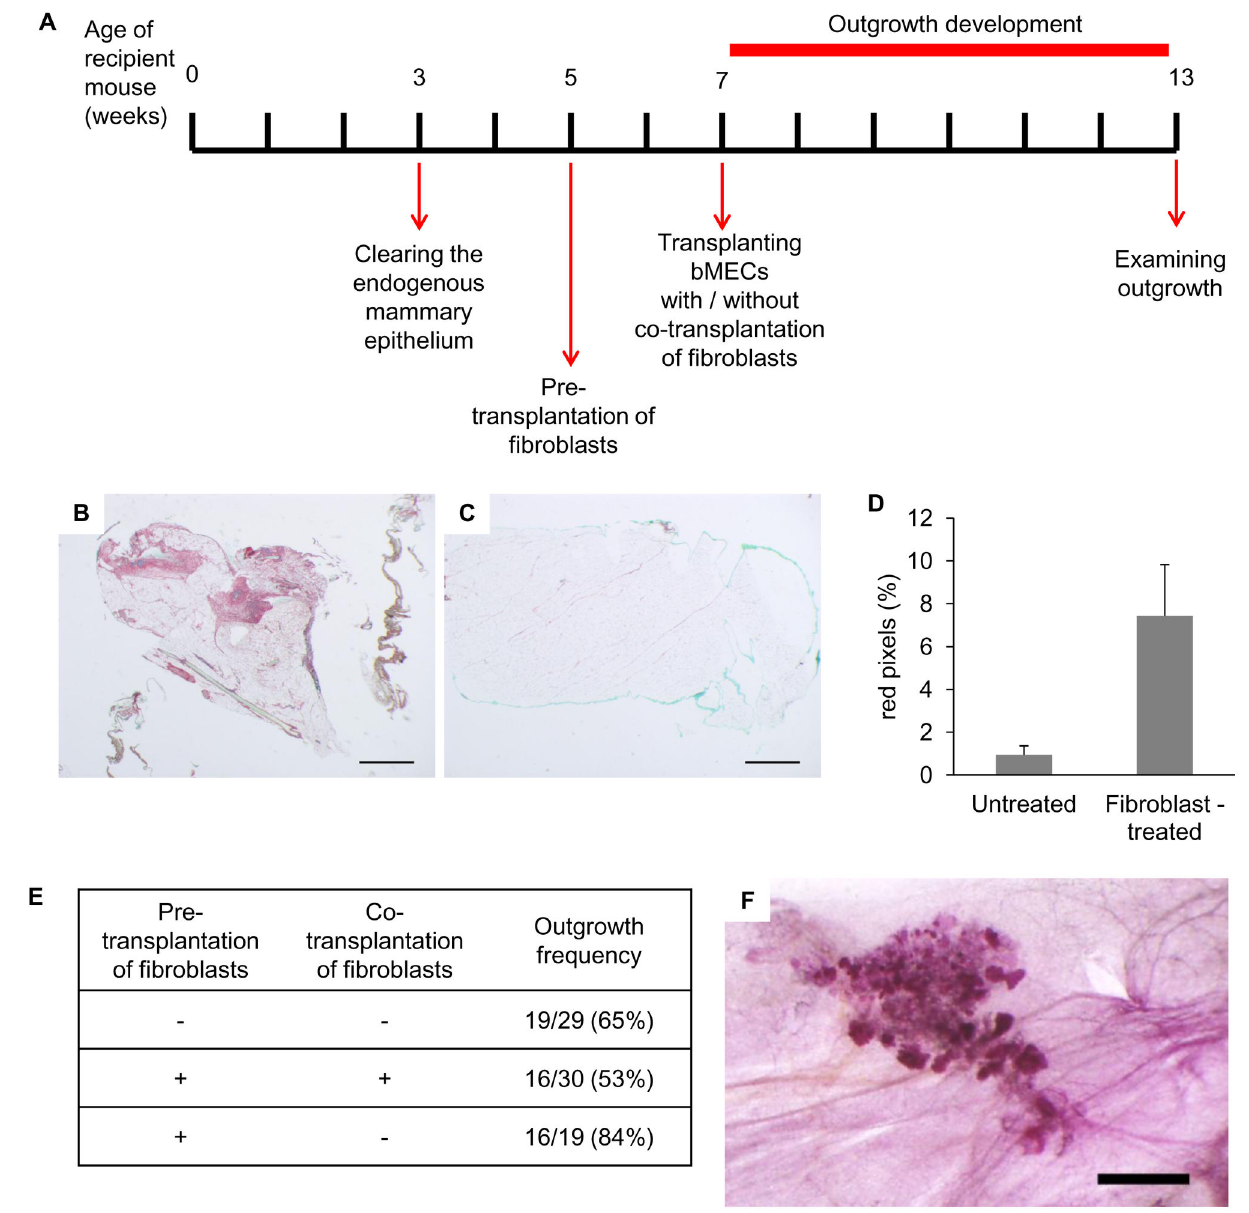
Figure 5. Differential effects for pre- and co-transplantation of fibroblasts on bMEC intake. A : Timeline of 10T1/2 fibroblast pre- and co-transplantation with bMECs. B , C : Representative Sirius red-stained tissue sections from cleared mammary fat pads, 2 weeks after fibroblast transplantation (B), or without intervention (C). D : The stained fibrotic area is significantly larger in fat pads transplanted with fibroblasts than in intact controls ( p = 0.02, n = 5, error bars represent SEM). Percentage of red pixels was calculated using the Adobe Photoshop software. E : Effects of pre- and co-transplantation of fibroblasts on outgrowth frequency. F : Representative Carmine-stained wholemount of bovine outgrowth that developed within the cleared mammary fat pad 2 weeks after fibroblast transplantation. Bar = 1